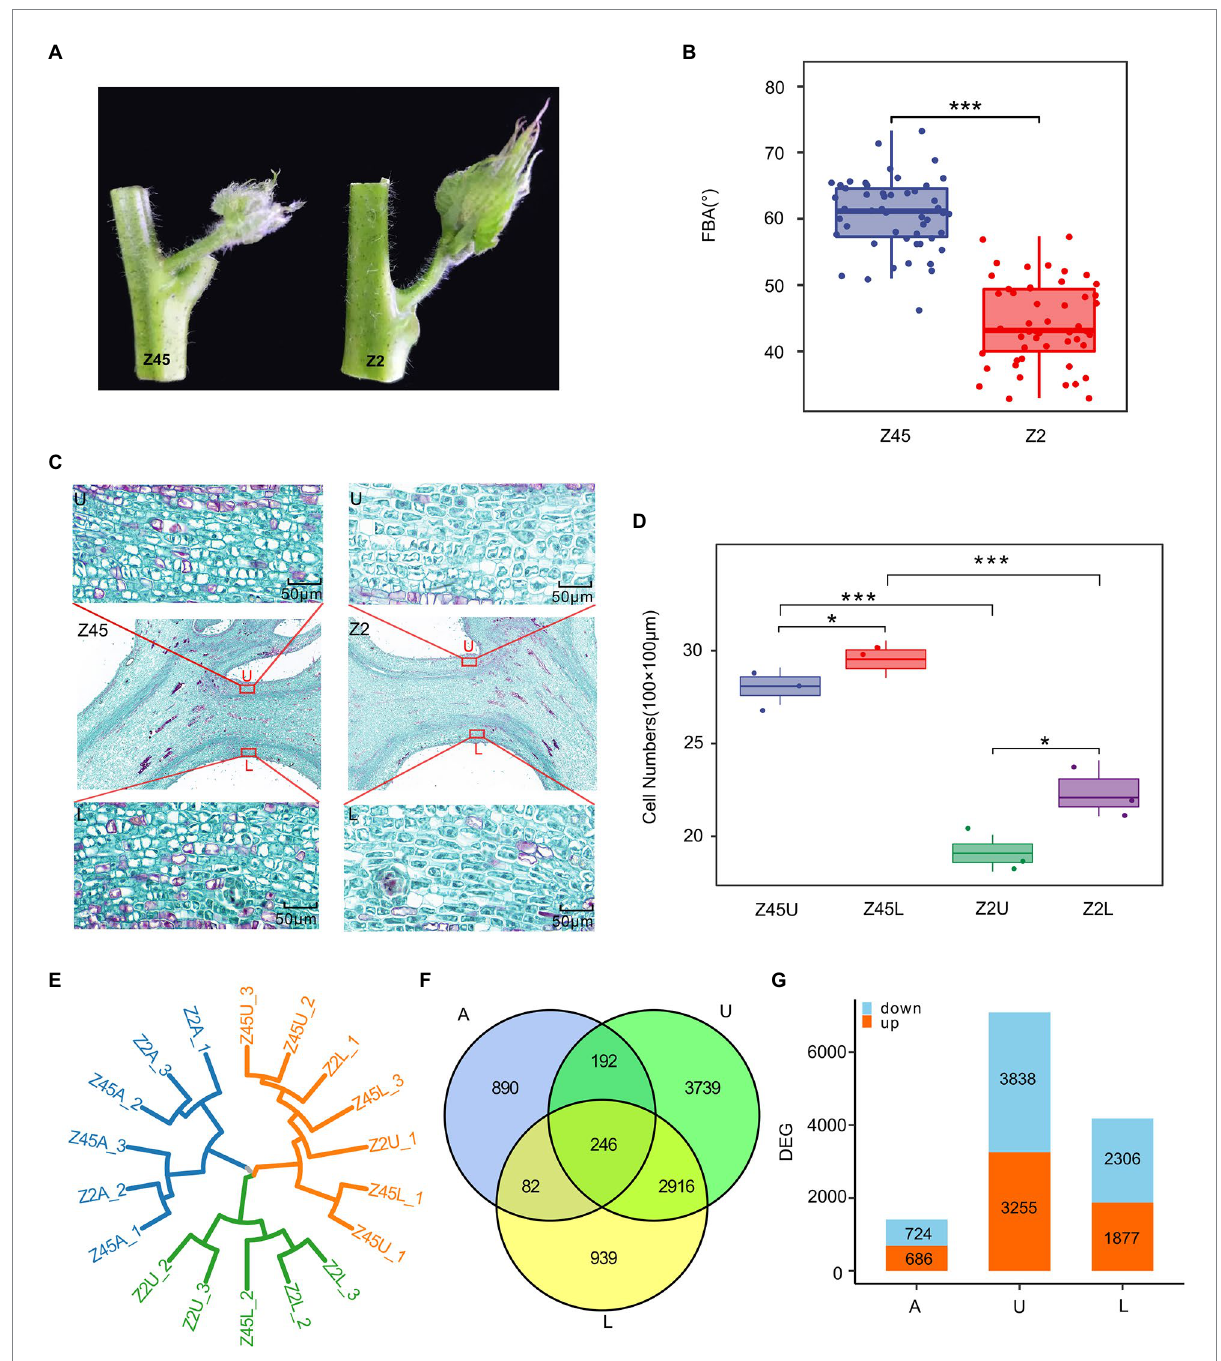
FIGURE 4 Transcriptome analysis of differentially expressed genes (DEGs) in different samples. (A) The FBA differences between Z45 and Z2. (B) The FBA of the Z2 and Z45 were shown by using boxplot. (C) Histological graph of the parenchyma cells in endodermis of Z2 and Z45 were shown. (D) The number of parenchyma cells in endodermis of upper side and lower side of two cultivars were shown. *Significant difference ( p < 0.05), ***Significant difference ( p < 0.001), t -test. (E) The cluster dendrogram of all samples were constructed. (F) Venn diagrams of DEGs among different sample were shown. (G) The numbers of up-regulated and down-regulated gene in different samples were shown by using the